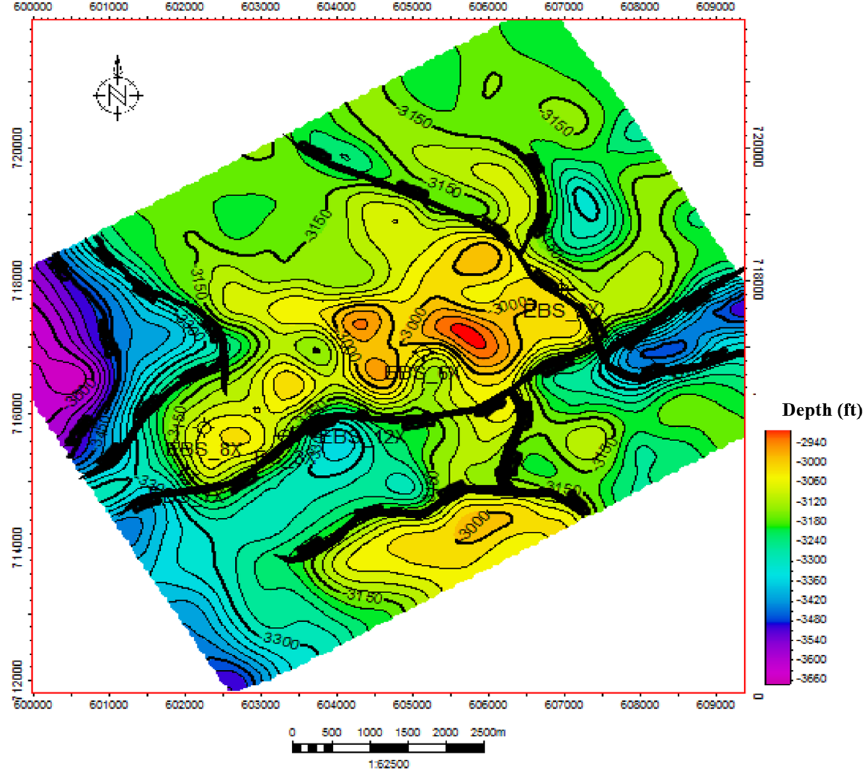
contour map on the top of Abu Roash Member(A)